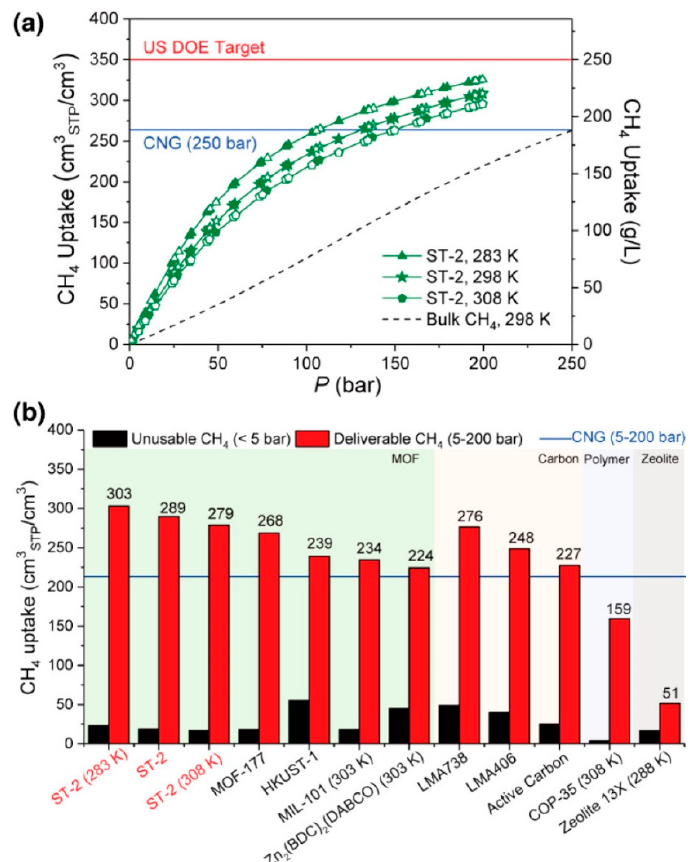
Figure 8. ( a ) Isotherms for methane uptake on ST-2 MOFs at di ff erent temperatures and pressures between 5–200 bar. ( b ) Deliverable capacity of ST MOFs as compared to other MOFs, activated carbon, zeolites, and CNG between 5–200 bar. Reprinted with permission from Ref. [50]. Copyright 2017 American Chemical Society.